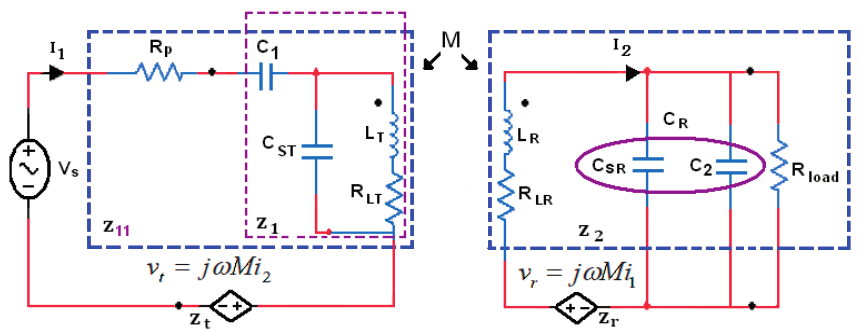
Figure 2. Inductive power link schematic and its equivalent